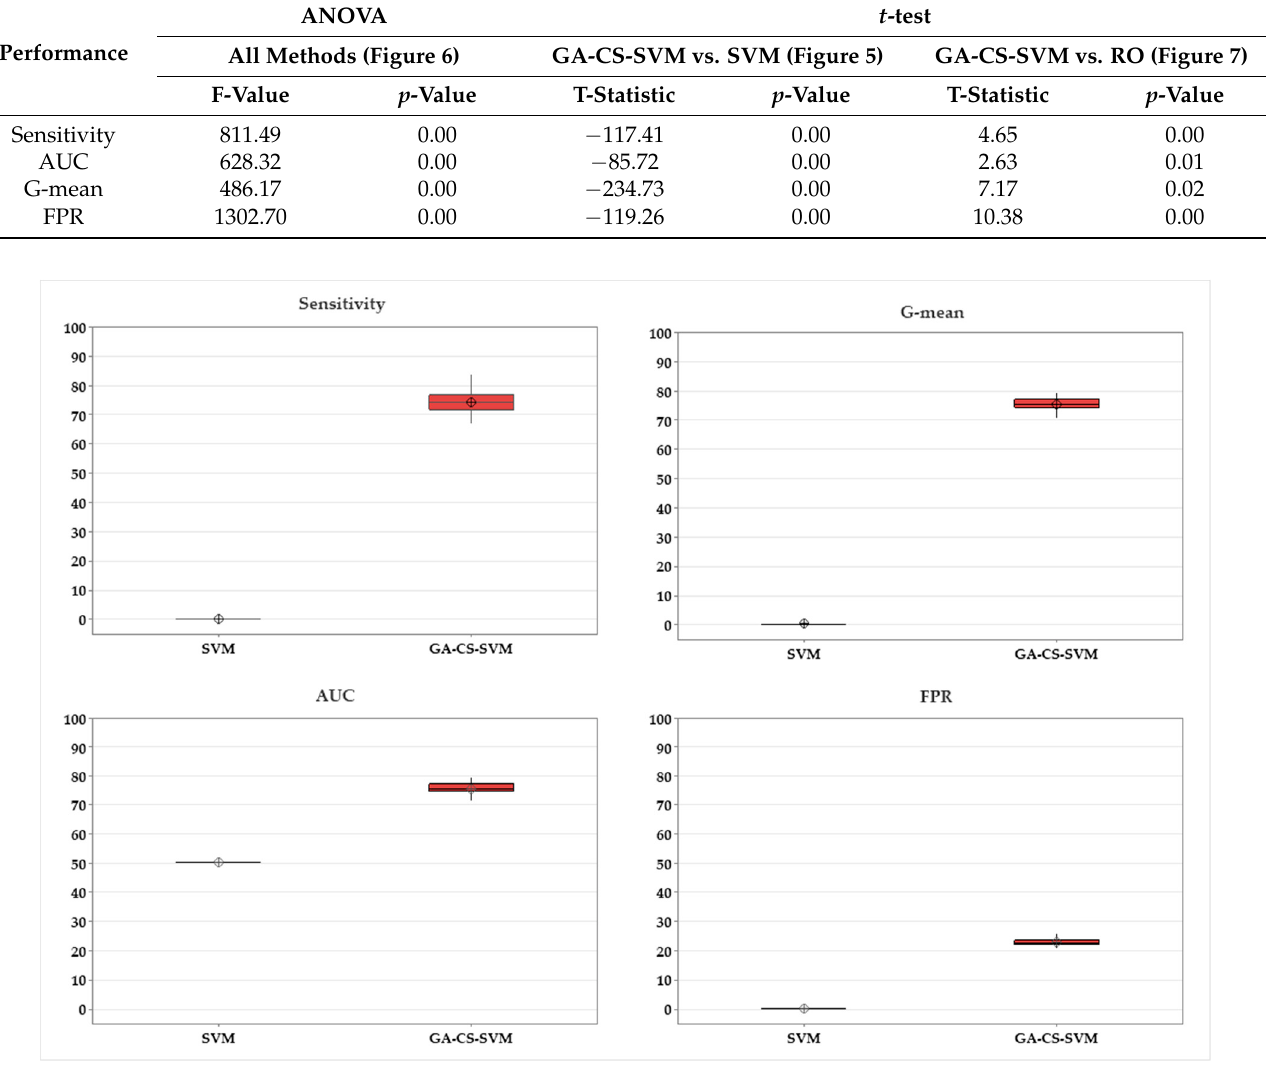
Figure 5. Comparison between GA-CS-SVM and SVM.